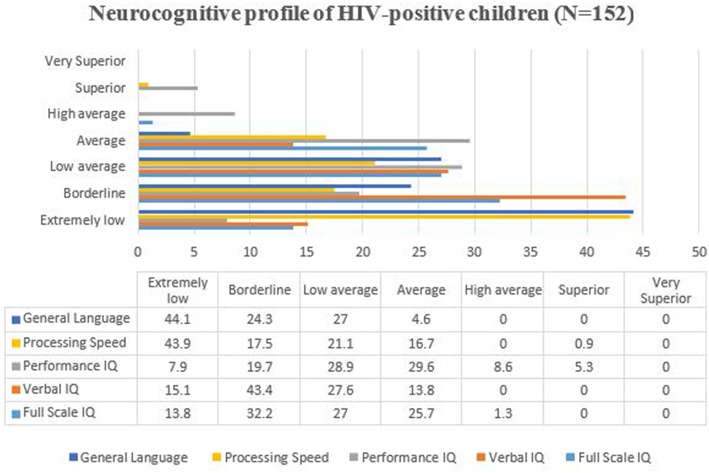
Neurocognitive profile of HIV-positive children in the study. The bars and figures represented the percentages of children in the different domain of IQ. IQ, Intellectual Quotient.